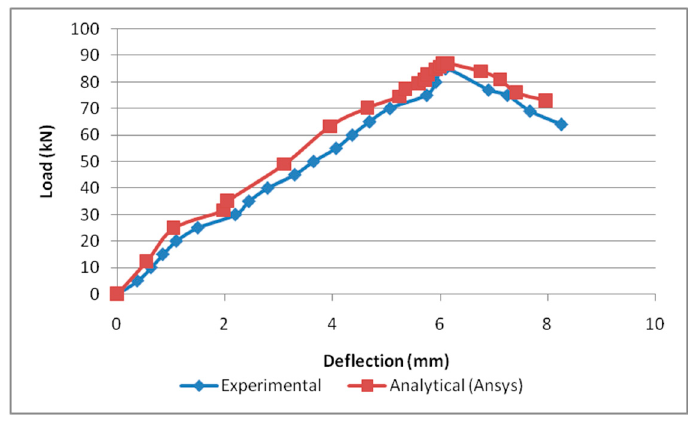
Figure 17. Load vs. deflection for B2B157.